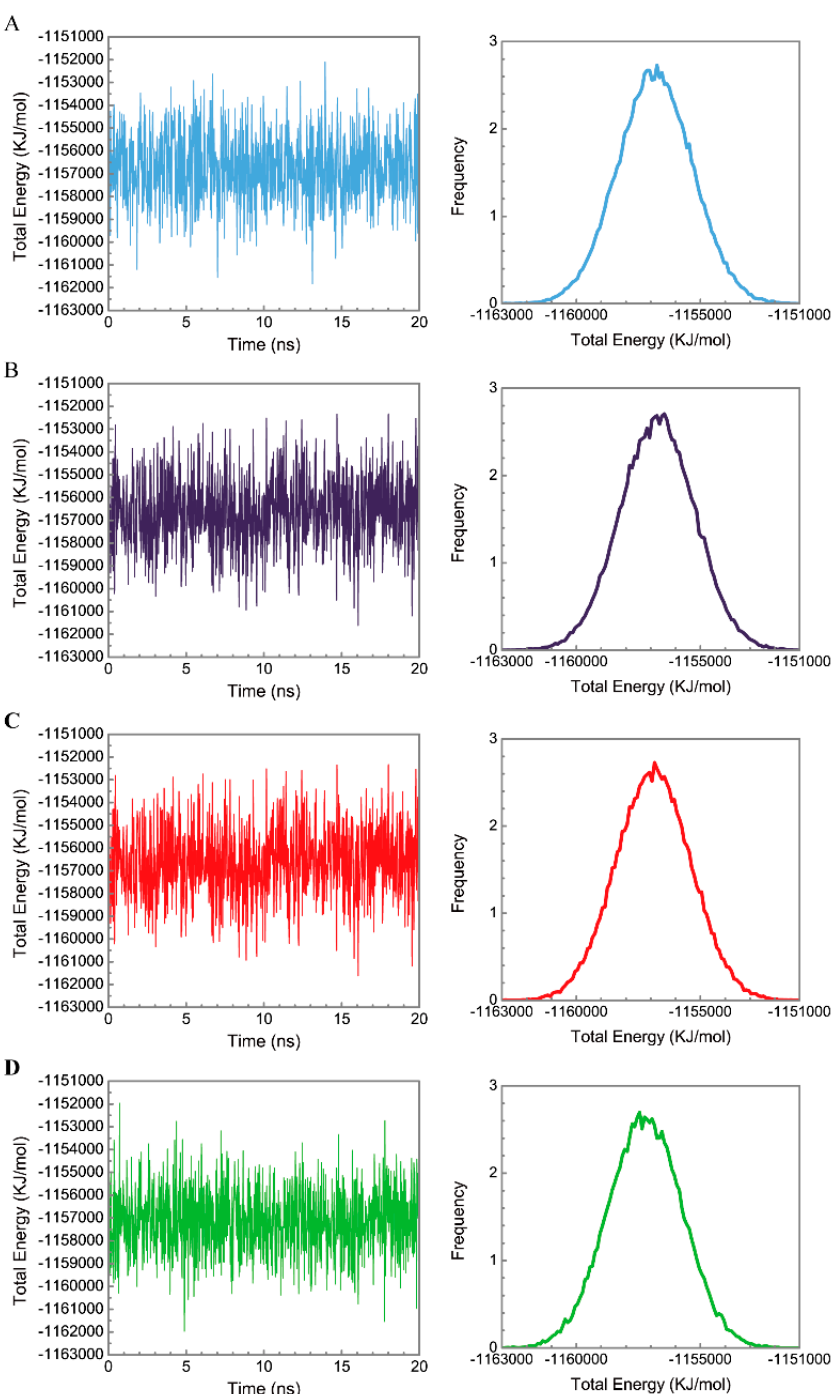
Figure 5. Variation of root-mean-square deviations, of ( A ) protein and ( B ) ligand over 20 ns for paraplegin in apo form and in complexes with three TCM candidates.